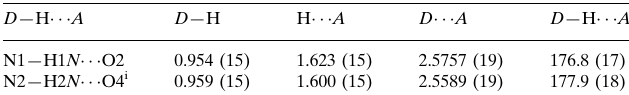
Hydrogen-bond geometry (A˚ , (cid:3)